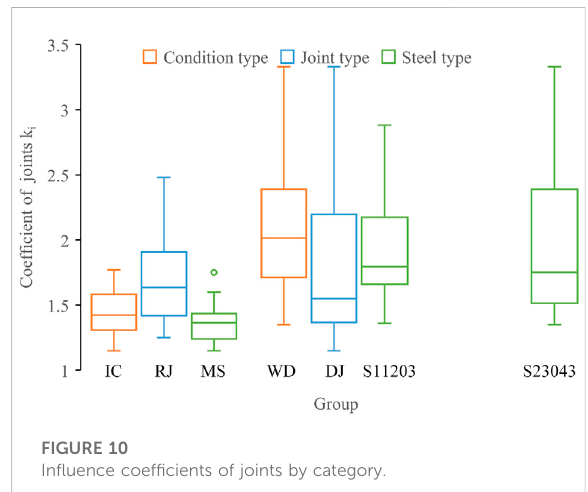
In fl uence coef fi cients of joints by